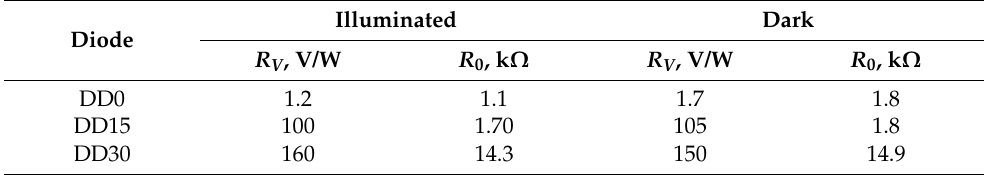
Table 4. Voltage responsivity R V and electrical resistance R 0 of the representative illuminated and darkened planar microwave